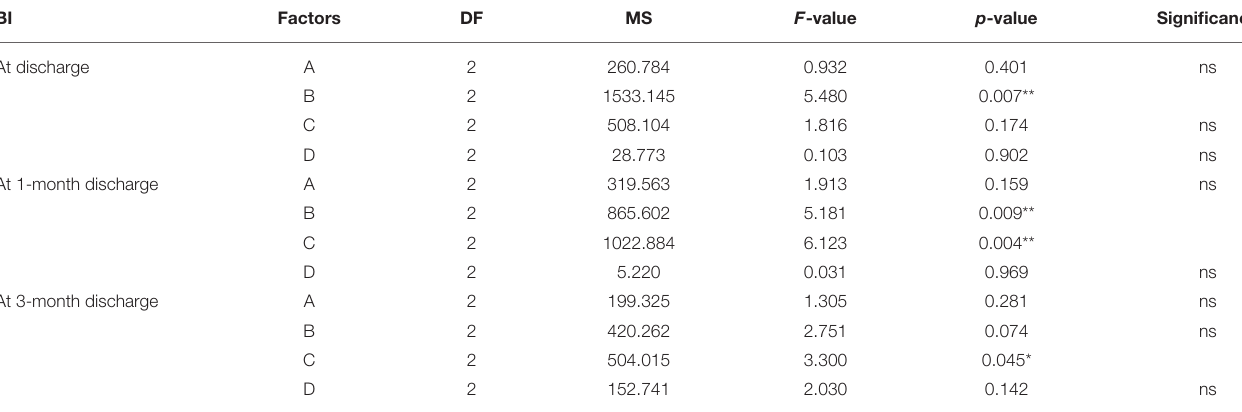
TABLE 6 | ANOVA of the factors affecting the Barthel Index.